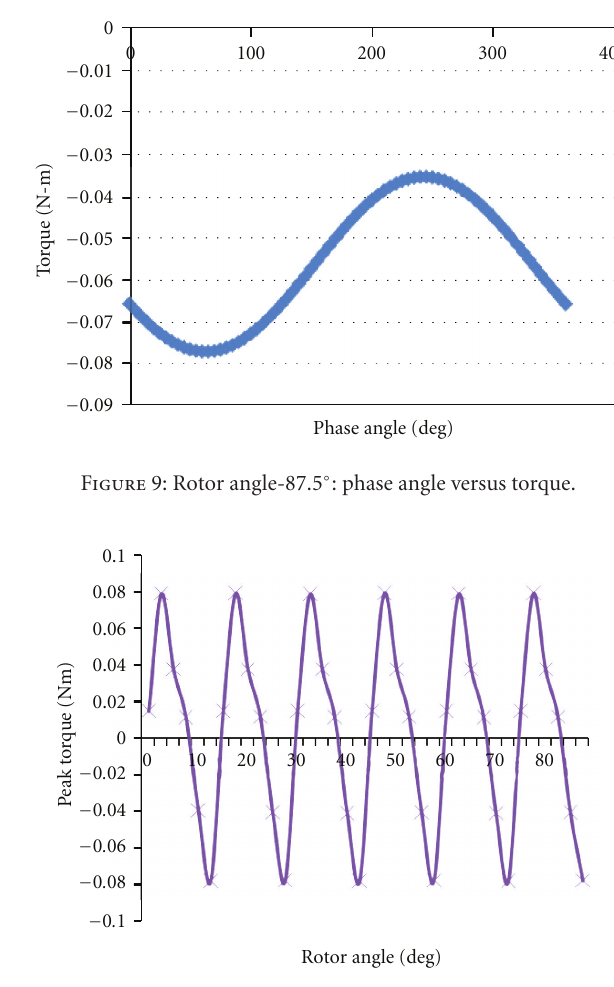
Figure 10: Rotor angle versus peak